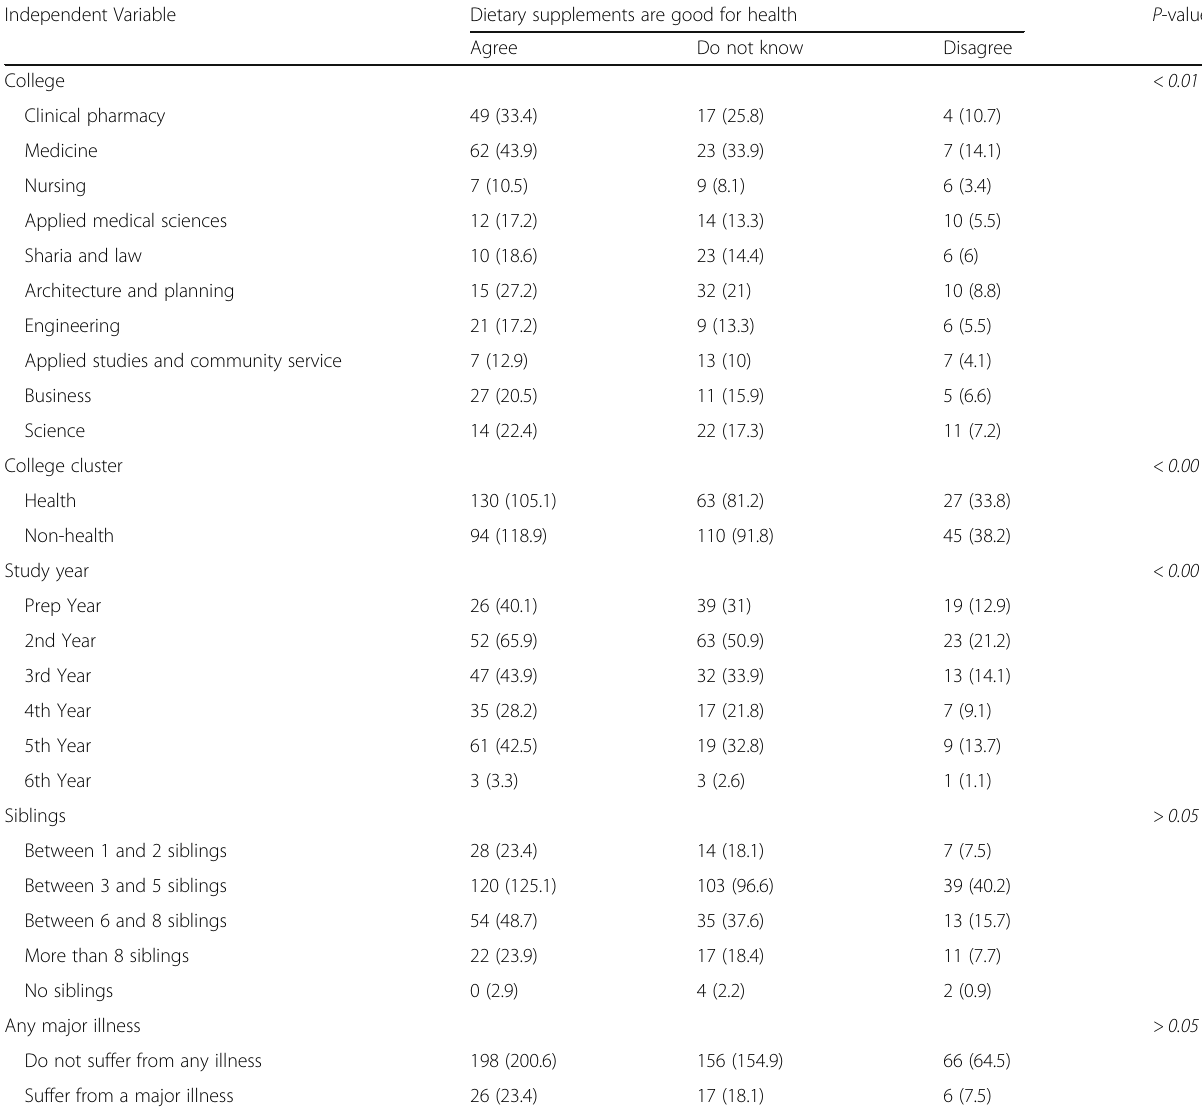
Table 5 Cross tabulation between students ’ demographic characteristics and opinion Independent Variable Dietary supplements are good for